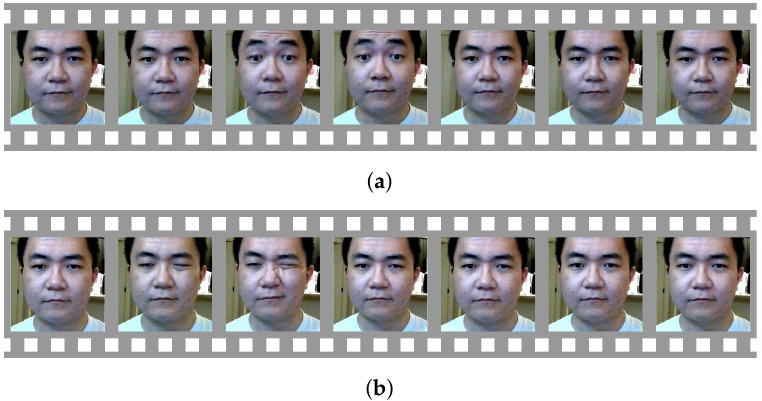
Figure 5. False positive example. ( a ) is a eyebrow-raising motion. ( b ) is a wink